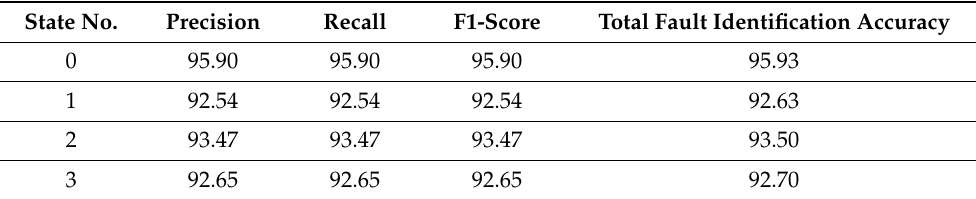
Table 9. Performance metrics values for each operating state.